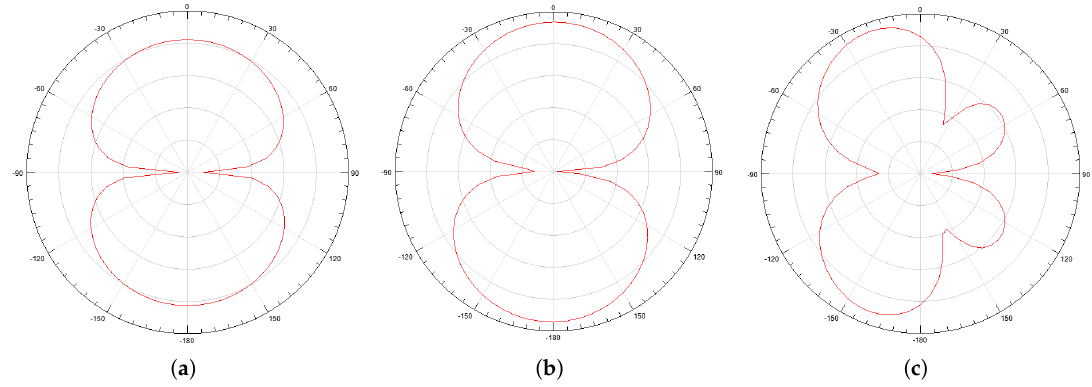
Figure 5. Antenna radiation pattern for: ( a ) 487 MHz; ( b ) 992 MHz; ( c ) 1497 MHz.